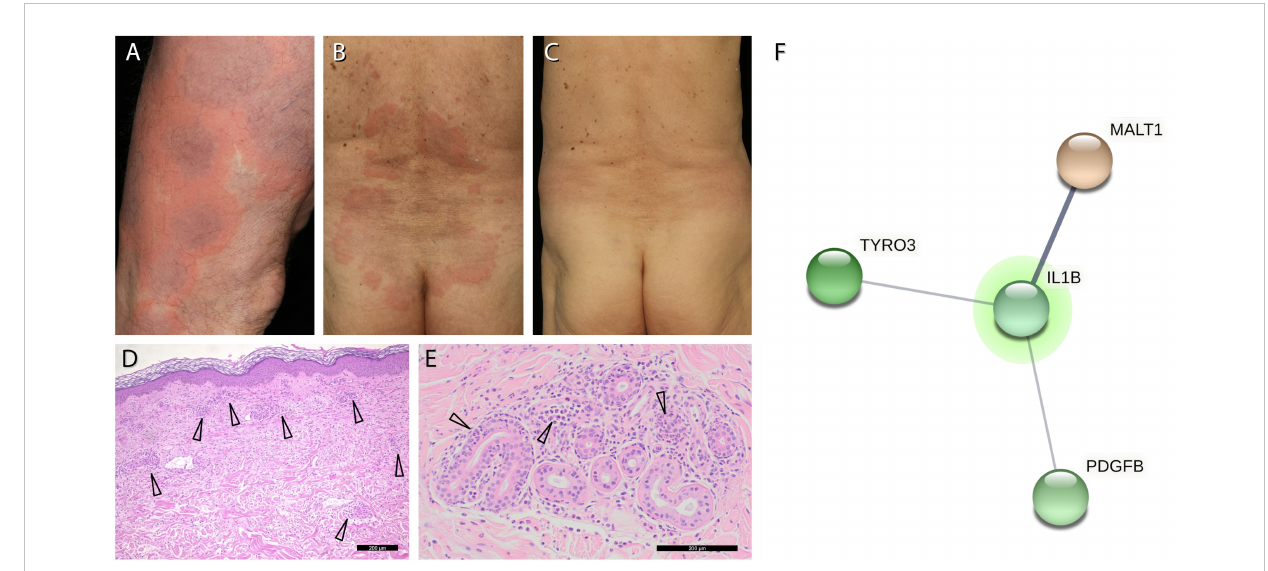
FIGURE 1 Clinical picture and genetic analysis. (A, B) , non-pruritic recurrent annular urticarial plaques on the extremities and on the trunk. (C) , resolution of urticarial plaques within hours in response to anakinra. (D) , Haematoxylin-eosin staining of a lesional skin biopsy shows a perivascular and interstitial neutrophilic in fi ltrate (arrows). (E) , Magni fi cation of panel (D) with neutrophils in the epithelium and excretory ducts of sweat glands (arrows). (F) , interaction network of the 3 genes with putatively deleterious somatic mutations that may affect the function of IL-1 b ( IL1B ) as primary mediator